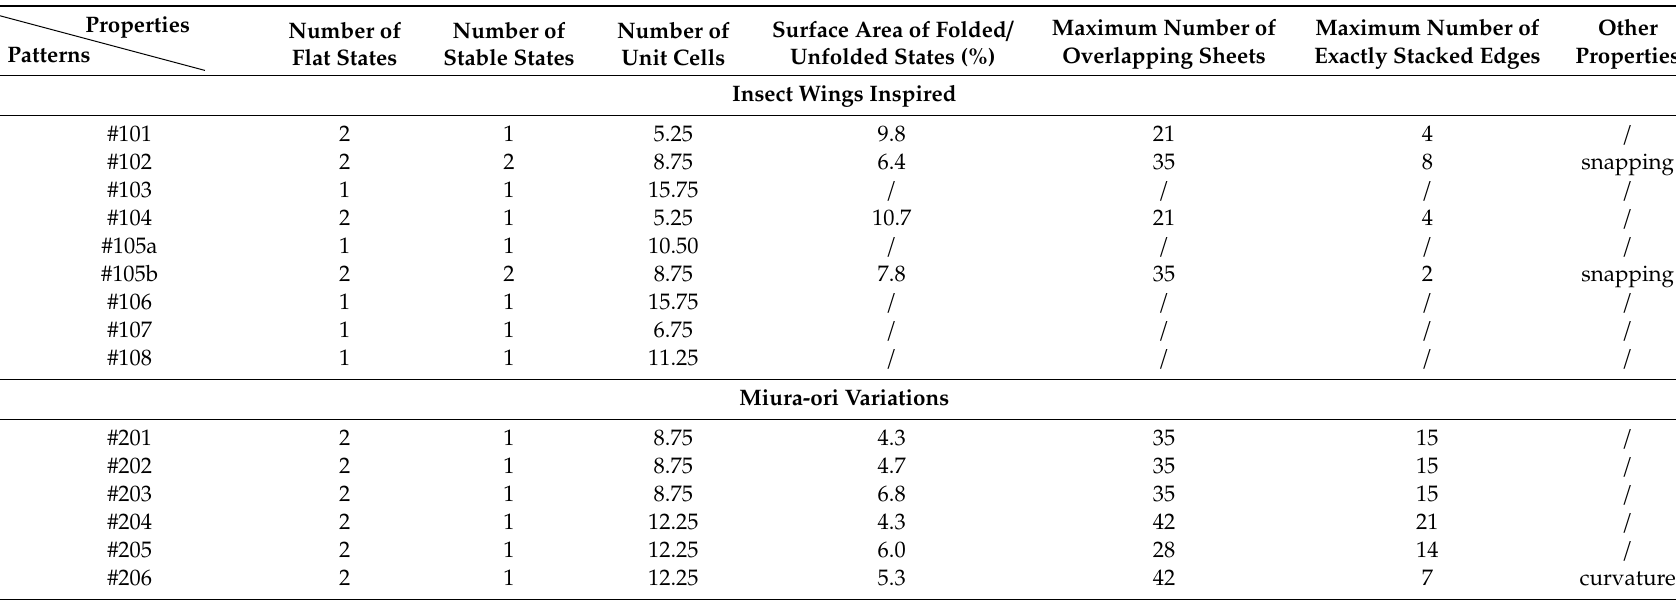
Table 1. Results of the analysis performed on the folding patterns generated to study their underlying properties. If the pattern could not be fully folded, no data could be collected for the surface area di ff erence, maximum number of overlapping sheets and exactly stacked edges as measurements from the folded state are needed.